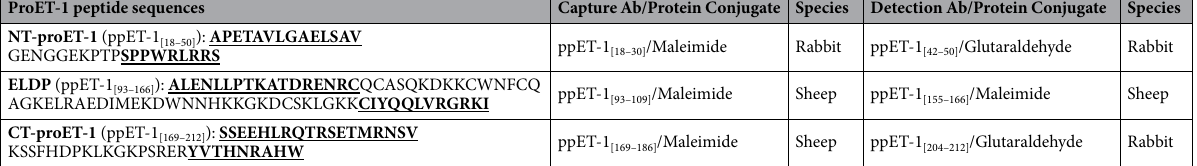
(Fig. 2C). NT-proET-1 (pI 6.3) immunoreactivity was mainly present in the unadsorbed pooled sample that had passed through both Q-Sepharose FF and Fractogel CEx. Subsequent isolation of NT-proET-1 immunore-